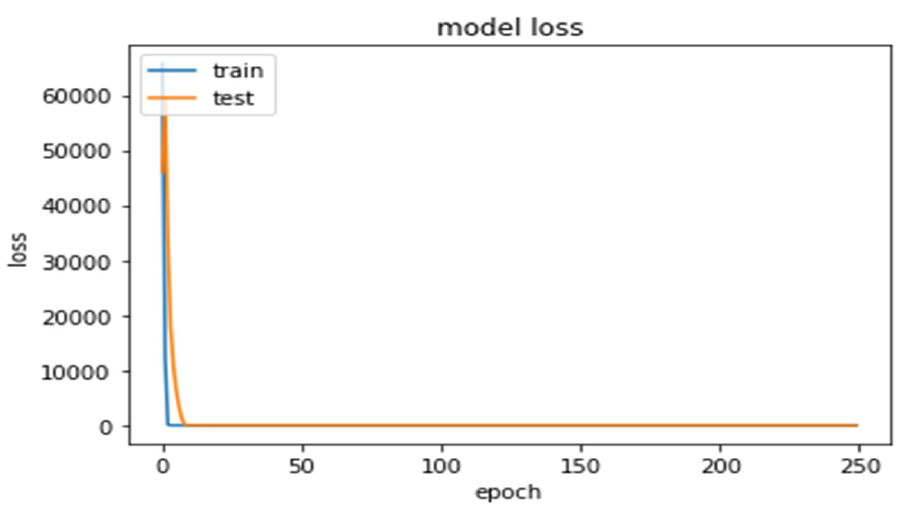
Figure 11. Model’s training and test loss with increased architecture.